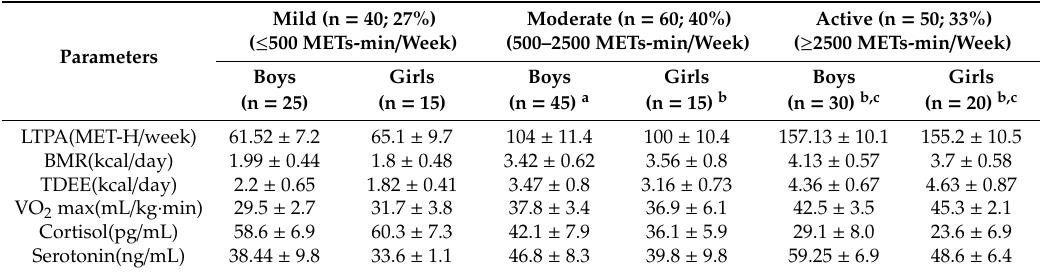
Table 2. Associations of cortisol, serotonin, BMR, TDEE, and VO 2 max with physical activity among participants (n =